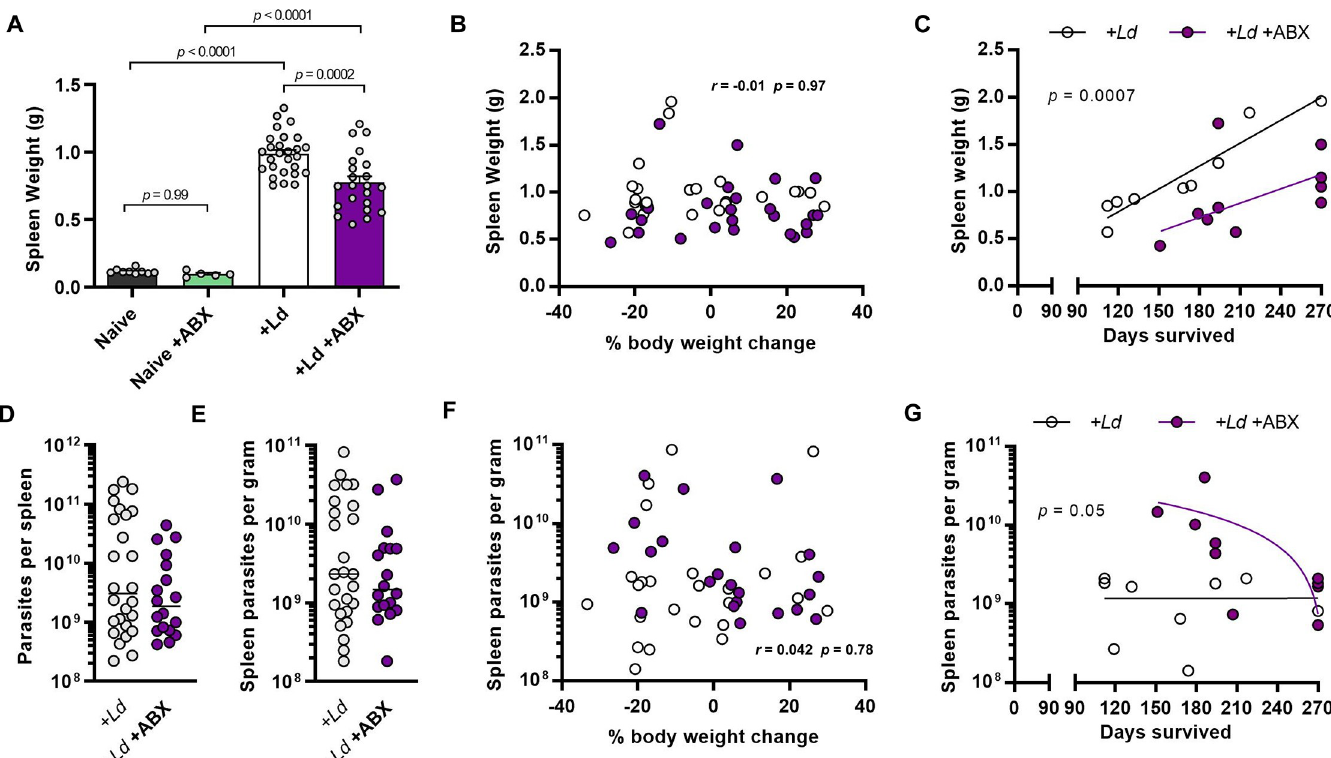
Fig 3. Prolonged survival in antibiotic treated hamsters is associated with less severe splenomegaly despite equivalent or higher parasite loads. (A) Spleen weights of hamsters at 12 weeks post-infection (p.i.) with L . donovani and given drinking water containing antibiotic cocktail (ABX) compared with uninfected na ï ve and untreated controls; p -values are from one way ANOVA. (B) Pairwise comparison and Pearson correlation test of splenomegaly severity and change in body weight (proxy for disease progression) at 12 weeks p.i. (C) Pairwise comparison between splenomegaly severity and time to humane end-point (fatal progression); p -value is from comparison of linear regression slope elevations. (D,E) Total parasite loads (D) and infection intensities (E) in spleens after 12 weeks of infection, measured by limiting dilution ex vivo culture assay. (F) Pairwise comparison and Pearson correlation test of spleen parasite densities and change in body weight (proxy for disease progression) at 12 weeks p.i. (G) Pairwise comparison between spleen parasite density and time to humane end-point (fatal progression); p -value is from comparison of linear regression slope elevations. In B-G data points are for individual hamsters treated with oral antibiotics (filled circles) and untreated controls (open circles). Analysis using VL onset end point (A,D,E), n = 5–27 per group; analysis using humane/maximum end-points (C, G), n = 9–10 per group; analysis using all endpoints (B,F), n = 22–25 per